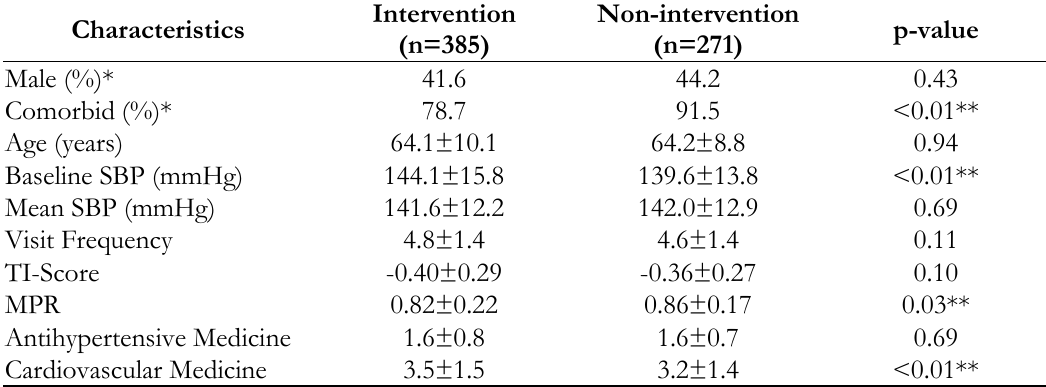
Table I. Baseline and pre-intervention period profiles of the intervention and non-intervention subjects